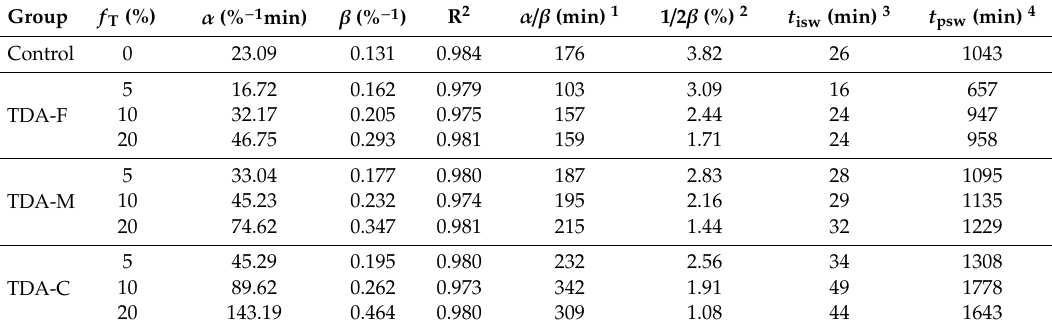
Table 4. Summary of the regression analyses outputs with respect to Equation